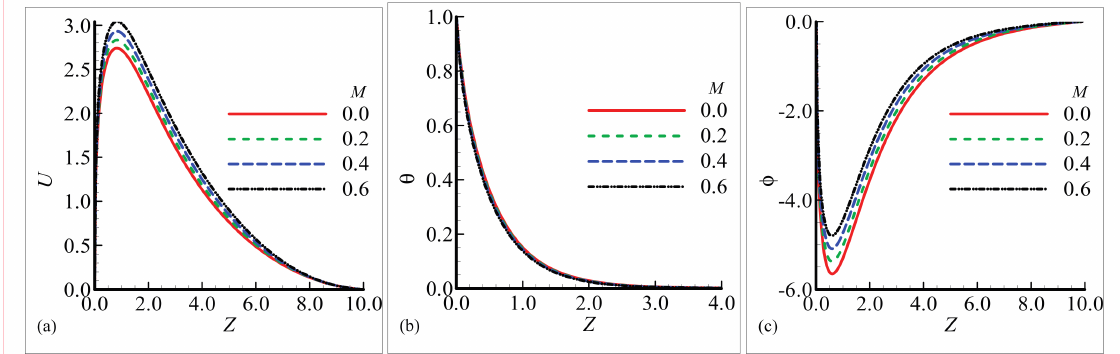
Figure 14. Physical e ff ects on quantities ( a ) u , ( b ) θ , and ( c ) φ versus, when Nt = 0.1, Nb = 0.4, Pr = 0.71, Q = 0.2, Sc =